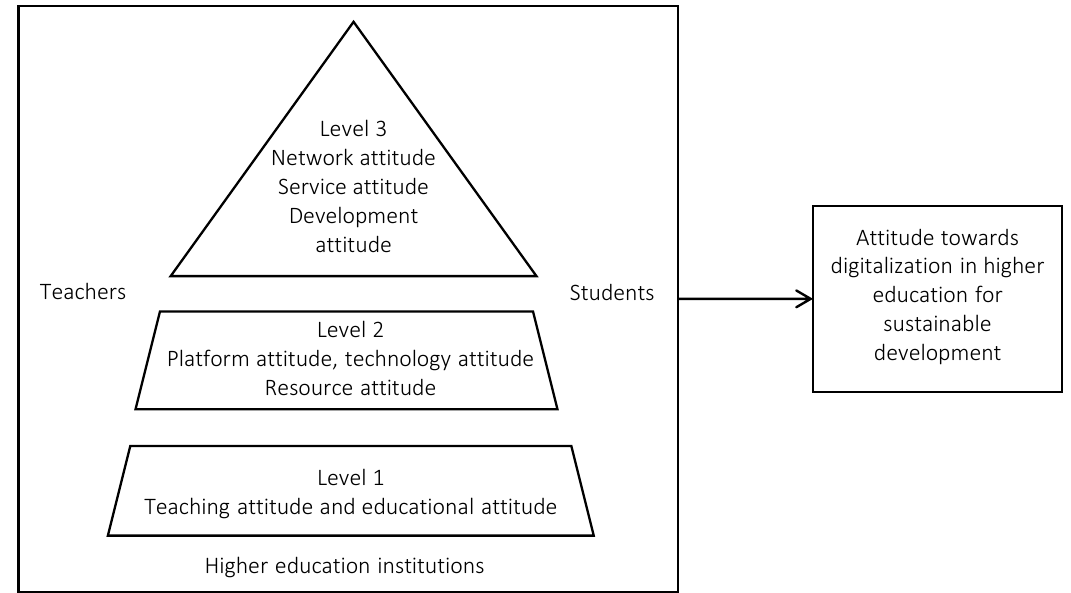
Figure 7. Conceptual framework of perceptions and attitudes towards digitalization in higher education for sustainable